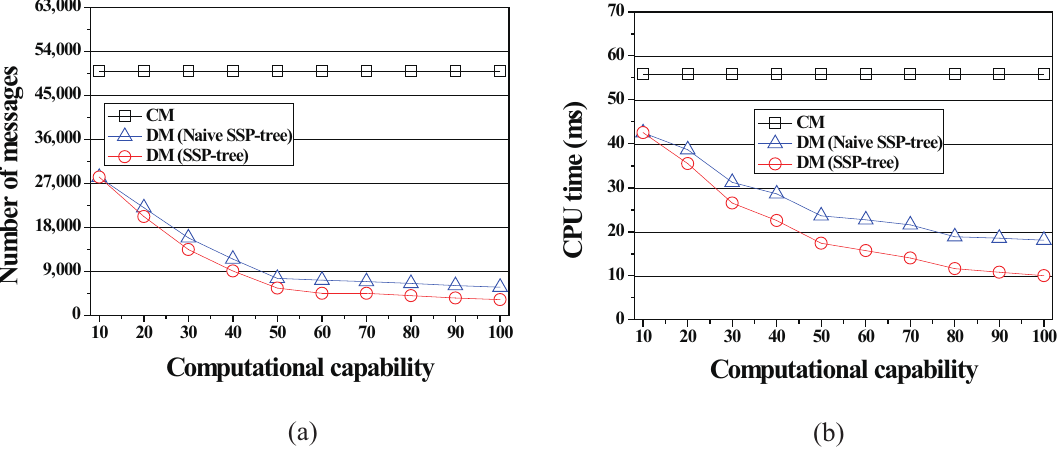
Figure 10. Effect of the minimum computational capability on the communication cost and the server computation cost. ( a ) Total number of messages vs. the minimum computational capability; ( b ) The amount of CPU-time vs. the minimum computational